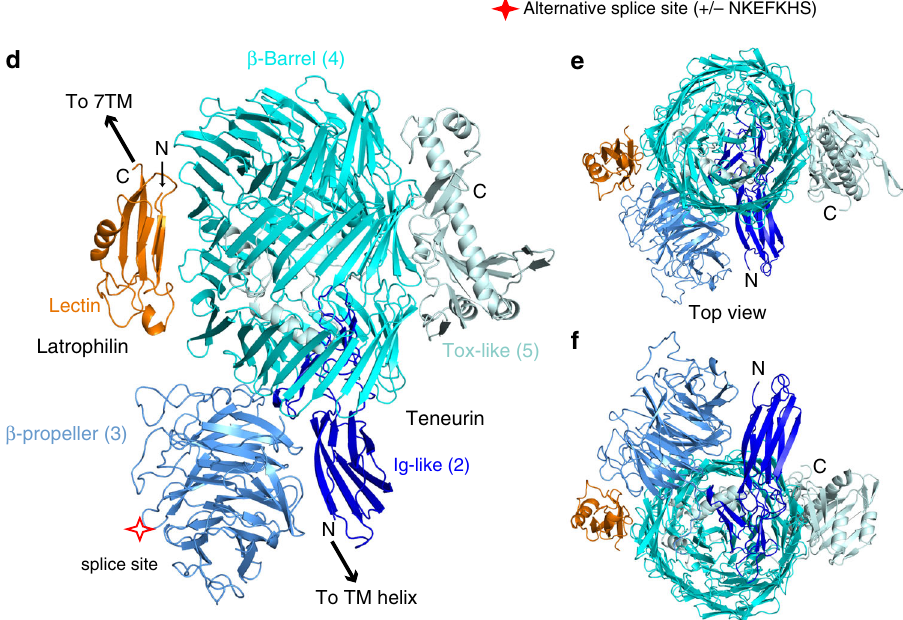
Fig. 1 The structure of the TEN2/LPHN3 complex. a Schematic diagram of human TEN2. Extracellular domains are colored gray, dark blue, sky blue, cyan, and palecyan for domains 1 – 5, respectively; transmembrane region (TM) in brown. Domain numbers and descriptions are indicated above scheme. b Schematic diagram of human LPHN3. Lec and Olf domain are colored orange; Hormone Receptor (HormR), GAIN and TM domains are colored gray. Splice site of TEN2 and LPHN3 are shown as red star and black stars, respectively. The constructs that were used in structure determination were TEN2 − SS and LPHN3 + SS. c Schematic diagram of the interaction network between TEN, LPHN, and FLRT at the synapse. TEN and FLRT are localized on the presynaptic cell membrane, while LPHN is localized on the postsynaptic membrane. TEN2 − SS isoform (empty red star) forms trans-cellular complexes with LPHN3 and induces excitatory postsynaptic specializations when LPHN3 simultaneously binds to FLRT3 (left). In contrast, TEN2 + SS isoform ( fi lled red star) induces inhibitory postsynaptic specializations independent of TEN2/LPHN3 interaction or FLRT3 binding (right). d – f The structure of the TEN2/LPHN3 complex as obtained from single-particle cryo-EM analysis. The Lec domain of LPHN3 binds to the side of the β -barrel of TEN. The alternatively spliced site within the β -propeller domain is distal to the Lec binding site on